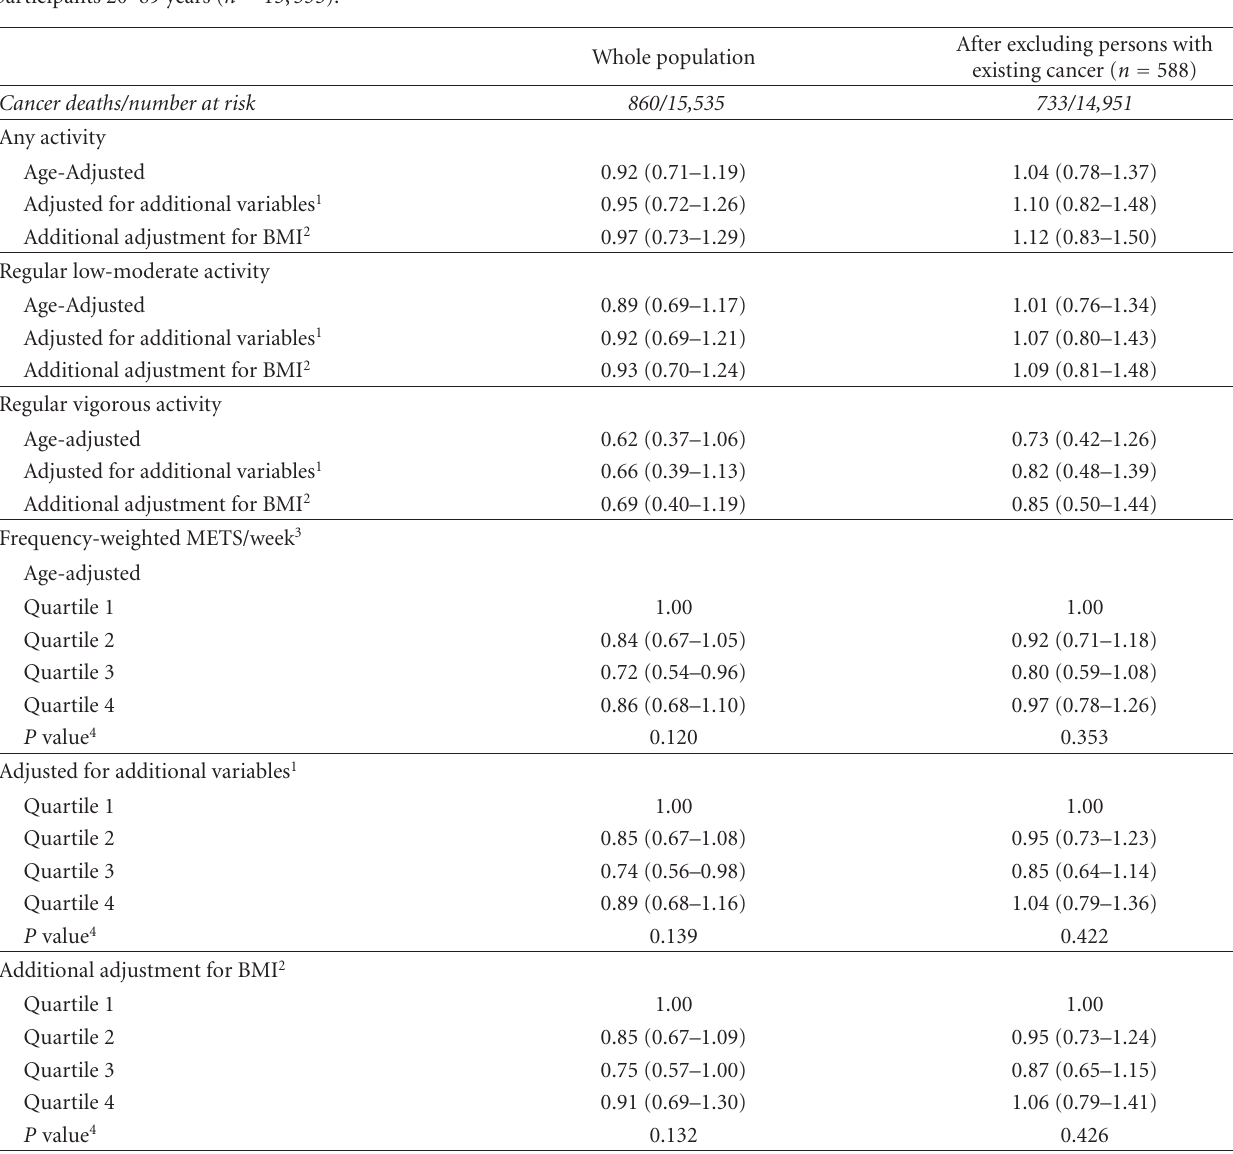
Table 2: Hazard ratio (HR) (95% CI) for cancer mortality and measures of leisure-time physical activity in NHANES III (1988–2006) participants 20–89 years ( n =